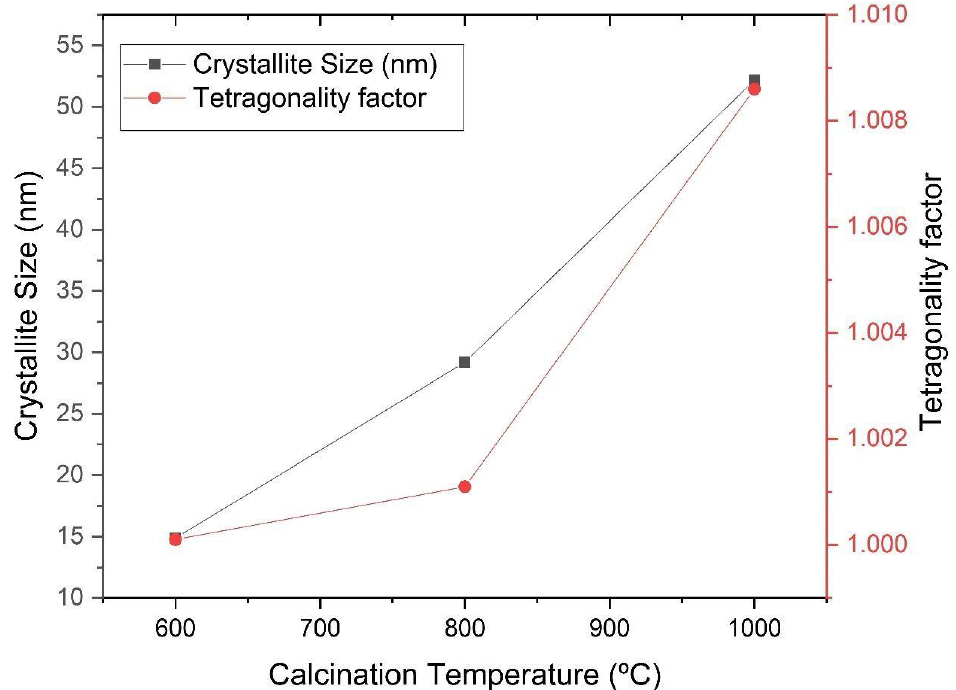
Figure 5. Size of the crystallite and tetragonality index as a function of the calcination temperature of the powders obtained by the sol-gel method and heat-treated at different temperatures (600 °C, 800 °C and 1000 °C).